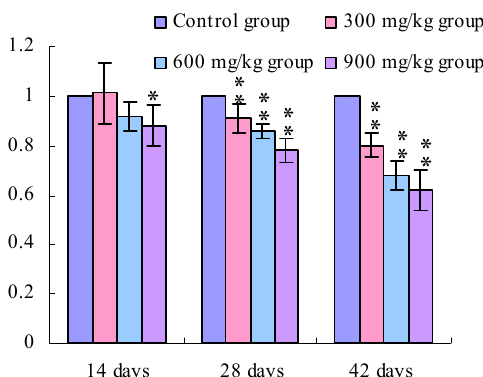
Figure 5. The TLR4 mRNA expression levels in the duodenal mucosa in